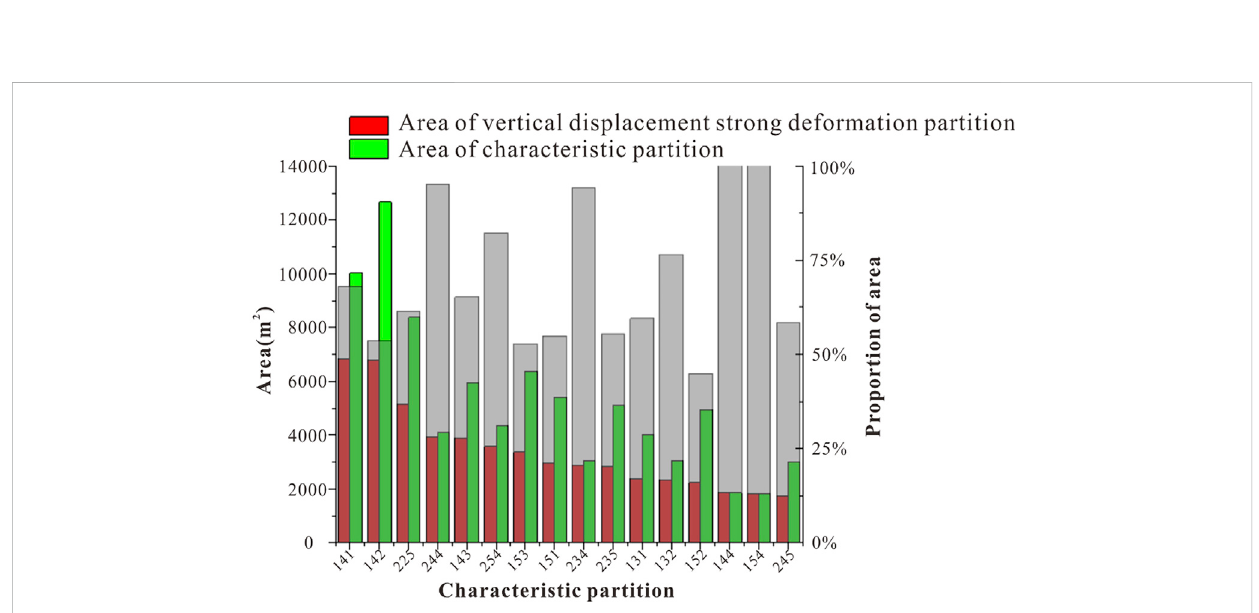
FIGURE 15 The ratio of the area of strong deformation of vertical displacement and its characteristic